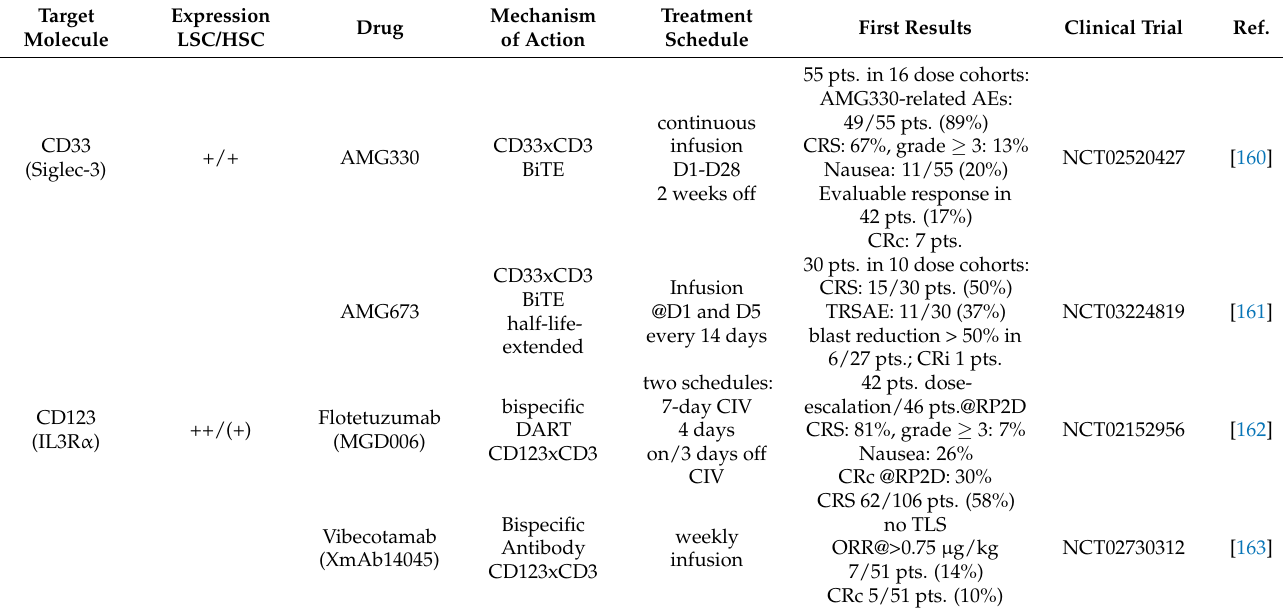
First Results Clinical